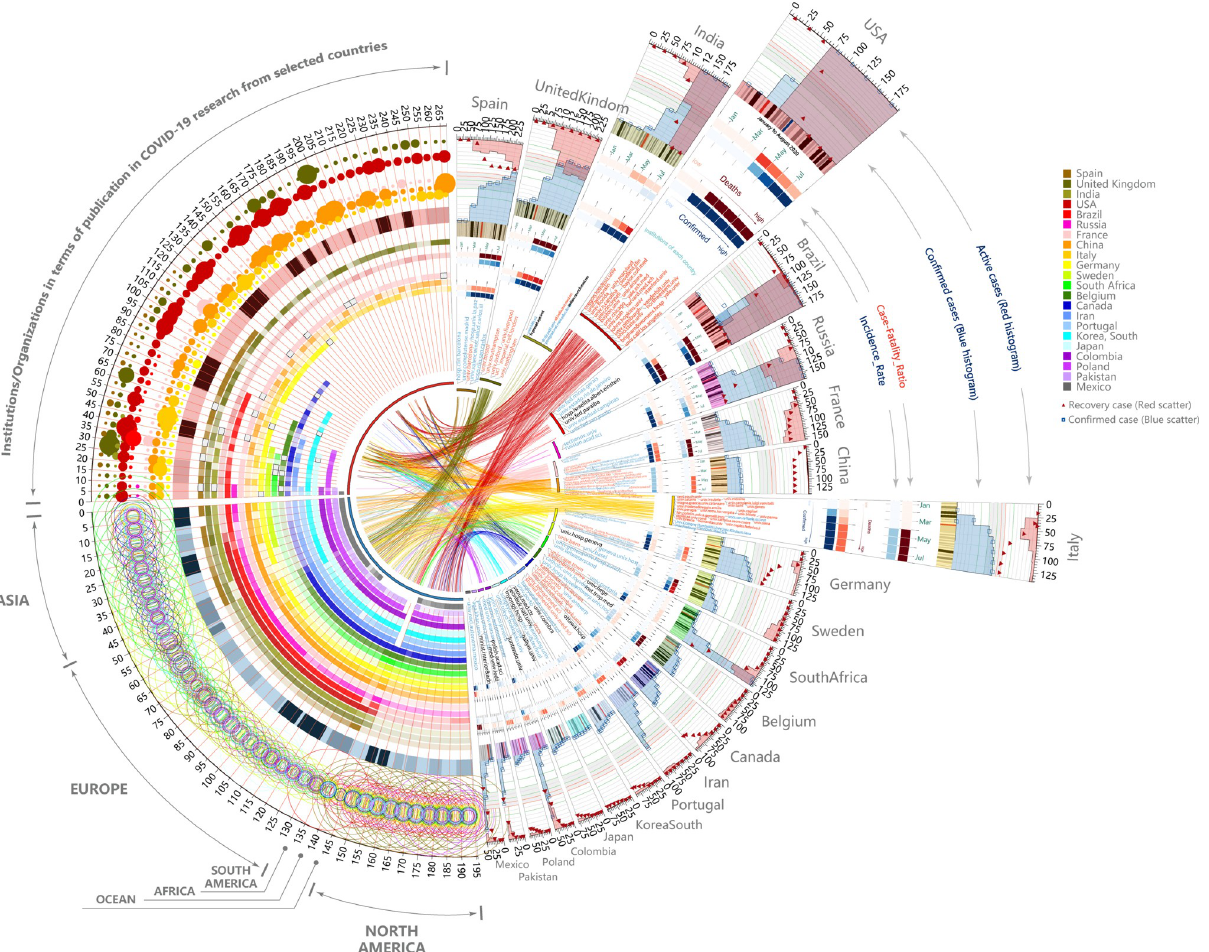
Fig 5. Quick glance over the current status of international collaboration and the COVID-19 pandemic, and the "global collaboration-pandemic control" imbalance. Scientific collaborations have always been regarded as critical actions to address global pandemics, however, we have noticed that in some nations, the increasing number of epidemiological studies or global collaboration has not brought well pandemic control, while in others the opposite has been the case. Based on the international cooperation participation and epidemiological situations, 22 nations were selected. The upper-left panel shows weight distribution of institutions/organizations in 22 nations; The lower-left panel shows the weight distribution of institutions/ organizations in the 6 continents; the right-half panel shows the outbreaks and important institutions/organizations in 22 nations. There seems to be no clear logics between the international cooperation participation and epidemiological